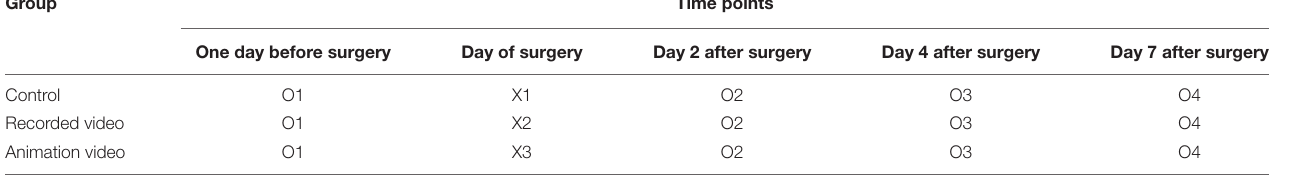
TABLE 2 | Time points of